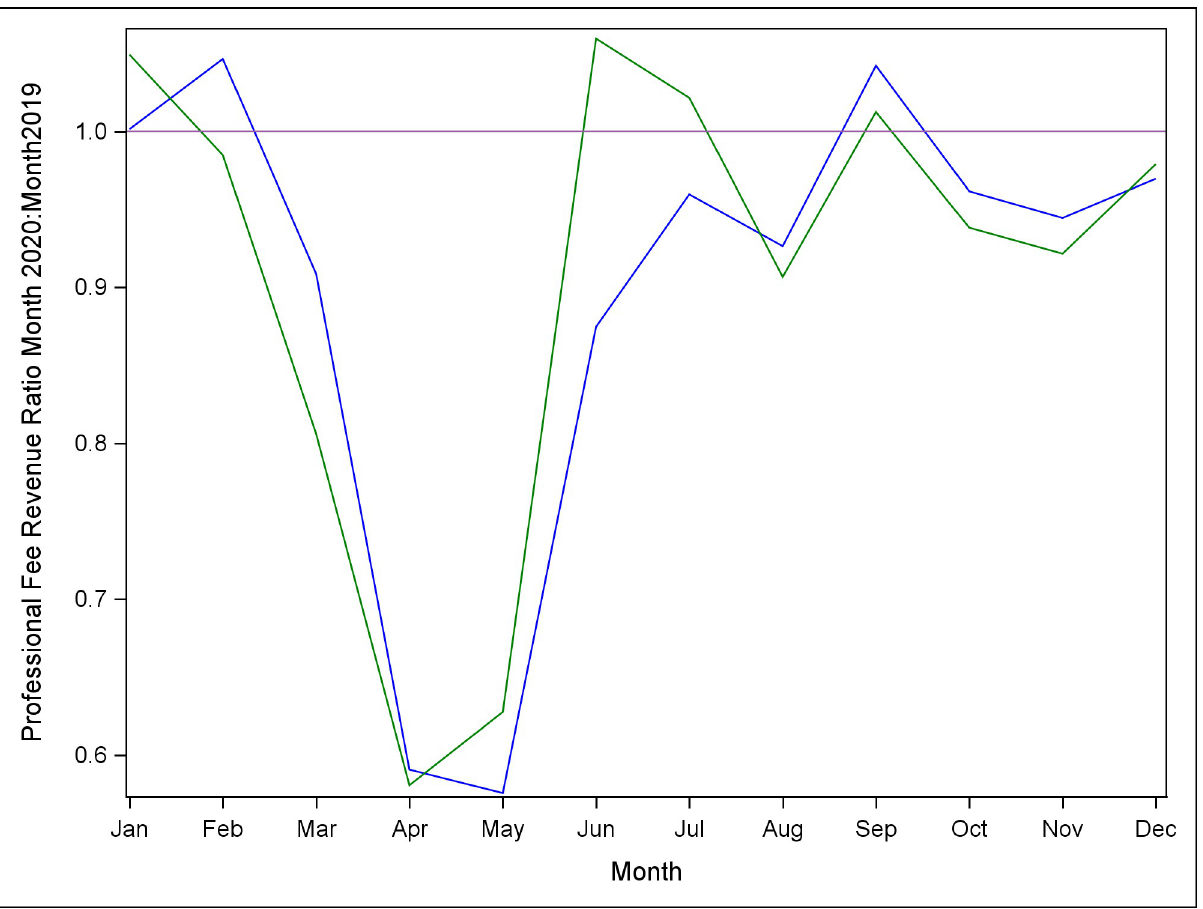
Fig 4. Ratio (2020:2019) of professional fee revenue, by month, for reach site. Blue line = Allegheny Health; Green line = Johns Hopkins.